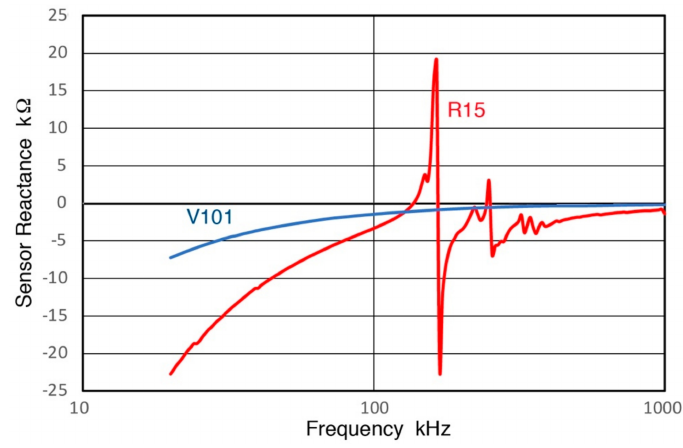
Figure 25. Reactive components of Z s are plotted against frequency for V101 (0.5) and R15